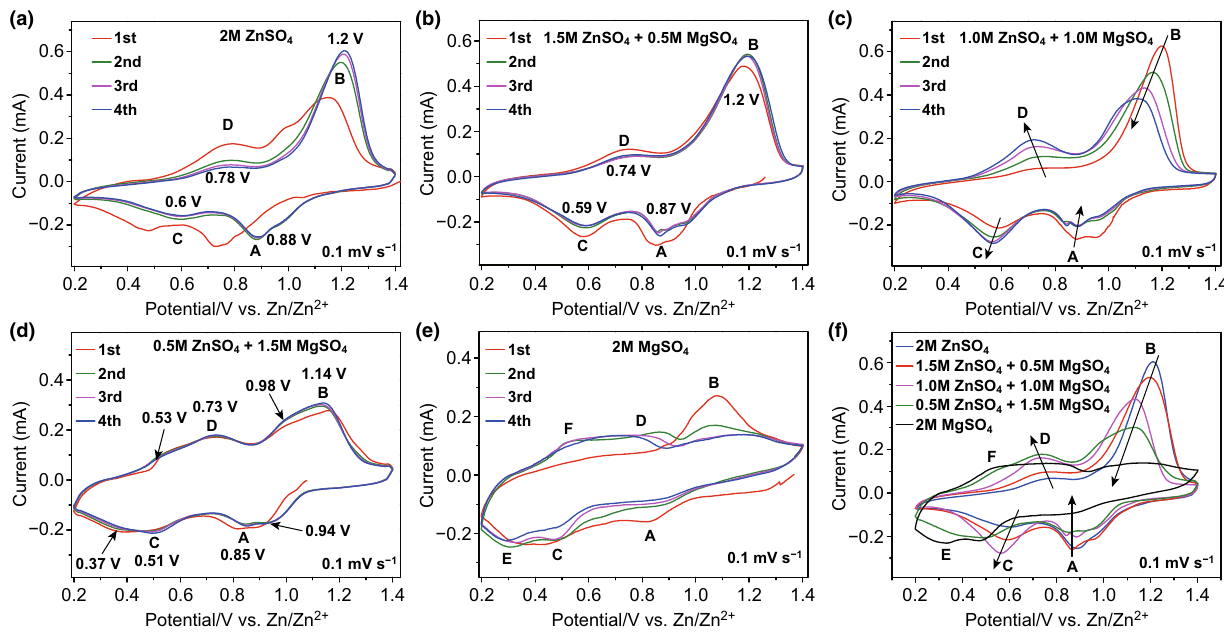
Fig. 2 CV profiles for MgVO cathode at scan rate of 0.1 mV s −1 in different electrolytes: a 2.0 M ZnSO 4 , b 1.5 M ZnSO 4 –0.5 M MgSO 4 , c 1.0 M ZnSO 4 –1.0 M MgSO 4 , d 0.5 M ZnSO 4 –1.5 M MgSO 4 , e 2.0 M MgSO 4 , and f the comparison of the third CV profiles in the five electro-